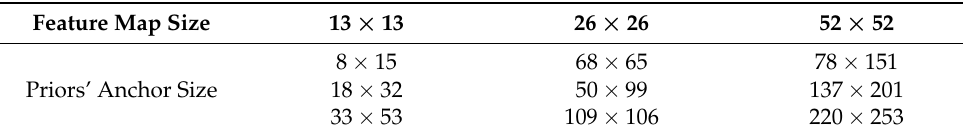
Figure 1. The visualization of k-means clustering on the PWMFD. We predict the width and height of the box as offsets from cluster centroids. Table 1. Bounding box priors obtained by